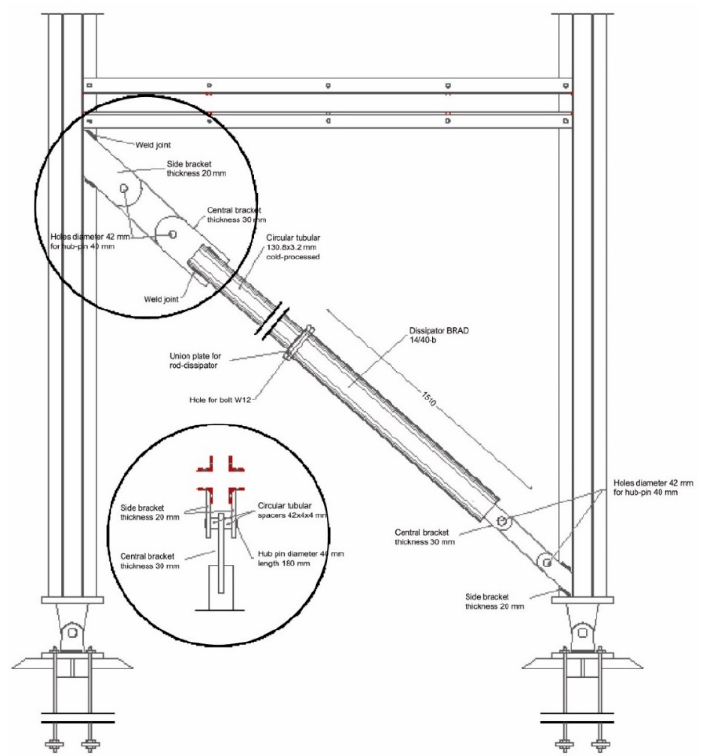
Figure 4. Buckling-restrained axial dampers (BRAD) 14/40-b dissipater inside the frame grid.